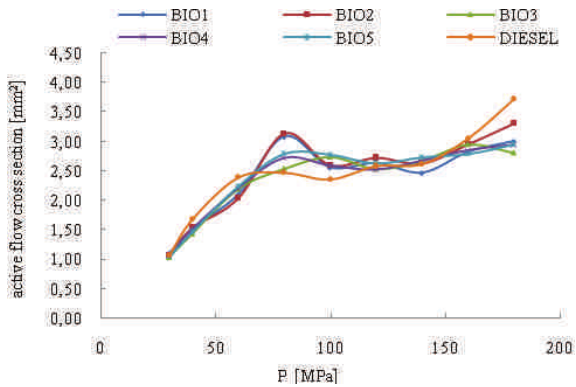
Fig. 4. Comparison of the active flow cross sections of tested fuels at